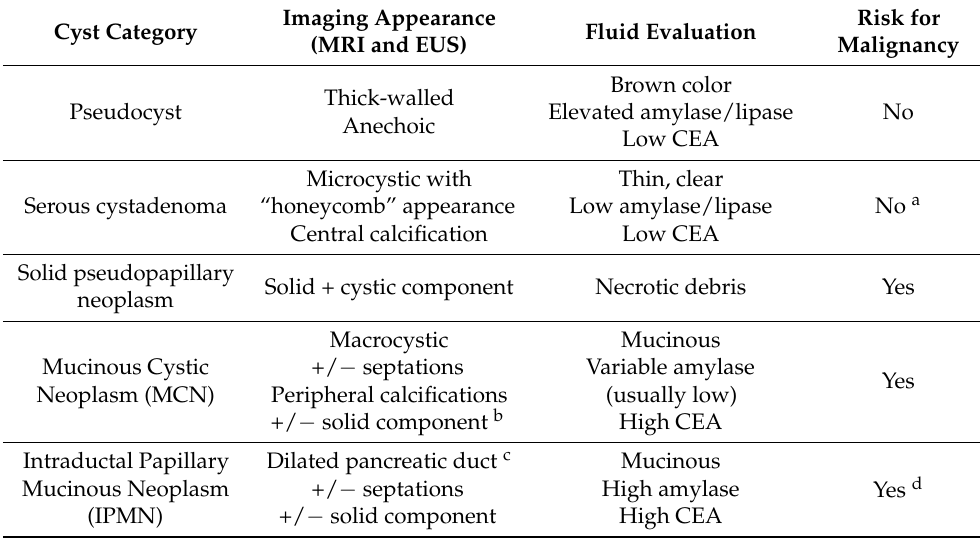
Table 2. Categories of Pancreatic